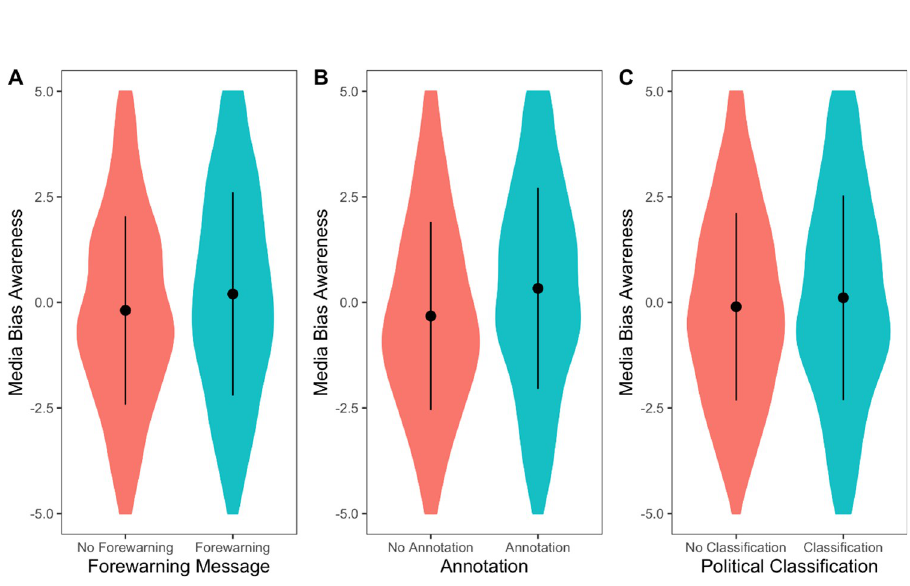
Fig 4. Effects of the interventions on media bias awareness. The forewarning message, as well as annotations, increased media bias awareness. Dots represent means, and lines are standard deviations.